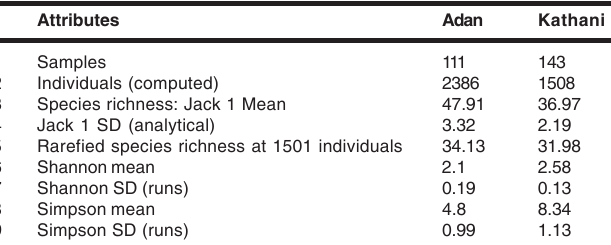
Figure 2. Number of fish species in different families (Both rivers combined) Table 3. Values of species richness, diversity indices for Adan and